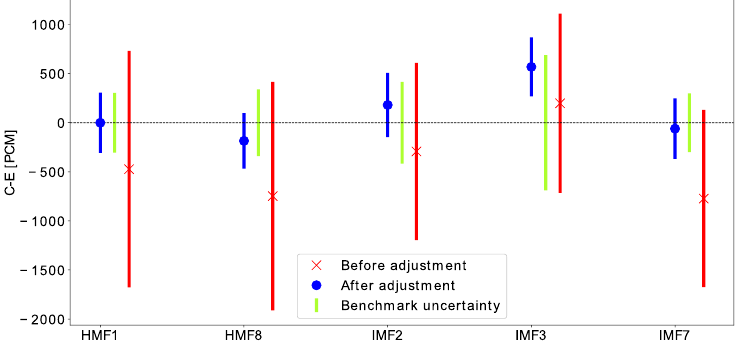
Fig. 3 Same as Fig. 2, but using the MLO technique to include σ extra . The green bars without marker contain the benchmark uncertainty including σ extra .